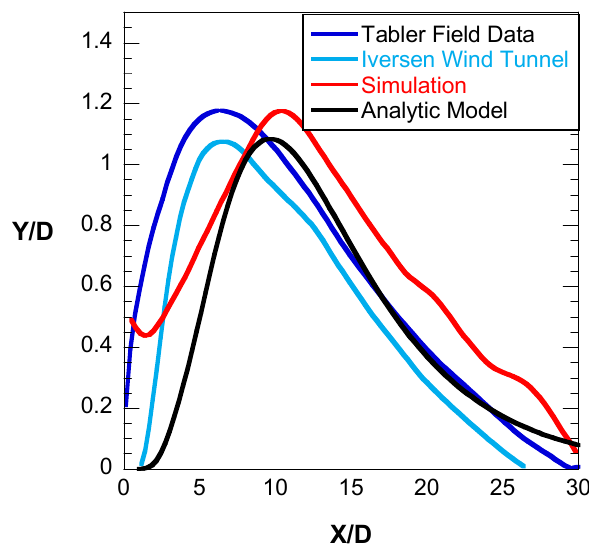
Figure 5. Deposition profiles of sand particles in the downstream of the fence.